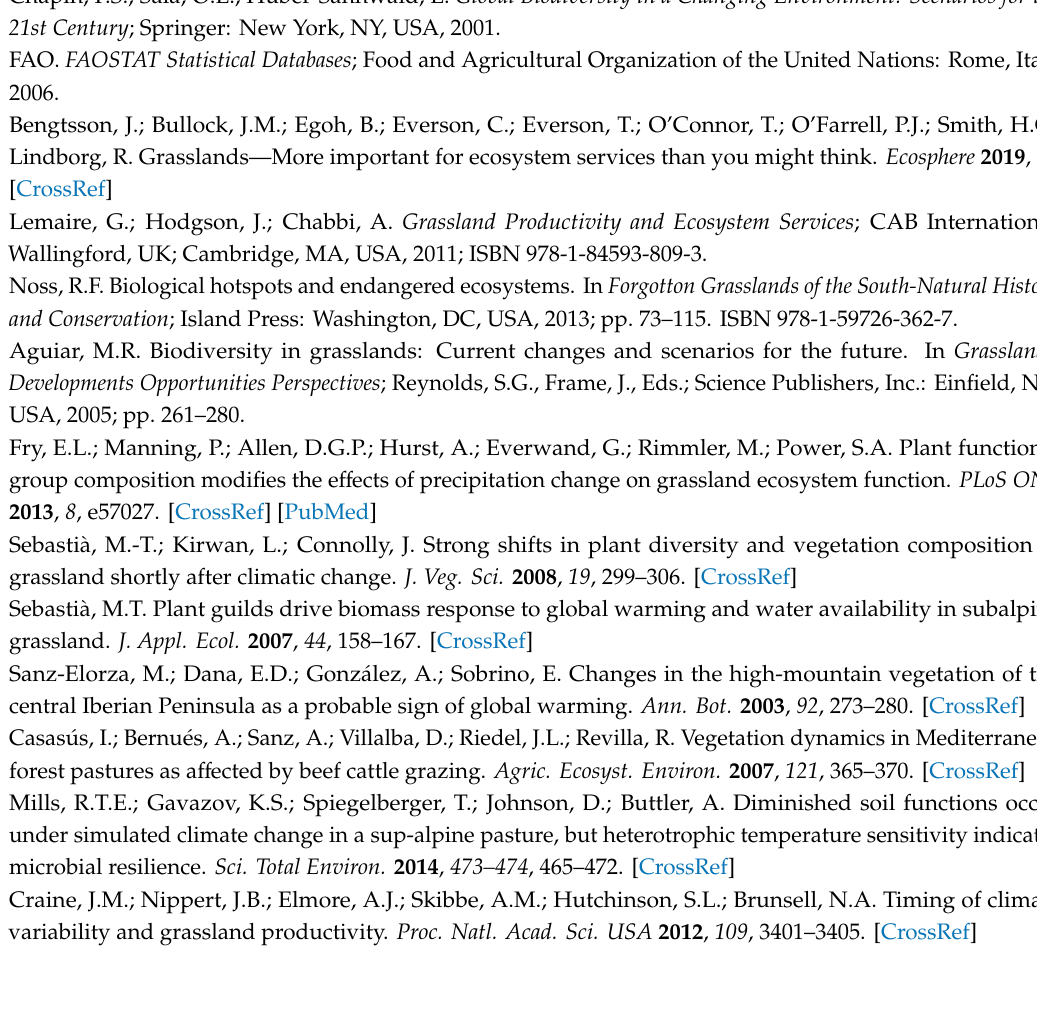
Figure S1: Schematic diagram depicting the sampling design in each study site; Figure S2: Correlation matrix of the variables used in the models; Table S1: Generalized diversity-interaction models for soil activity and fertility parameters (response